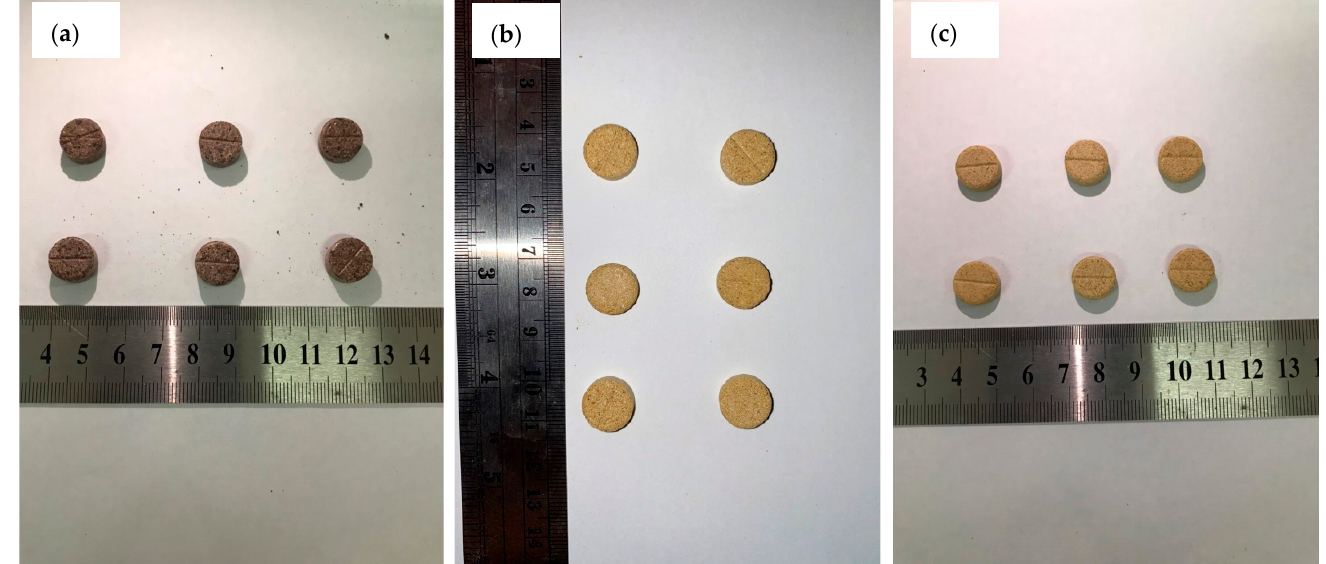
Figure 4. Tablet appearance of formula F1 ( a ), formula F2 ( b ), and formula F3 ( c ).